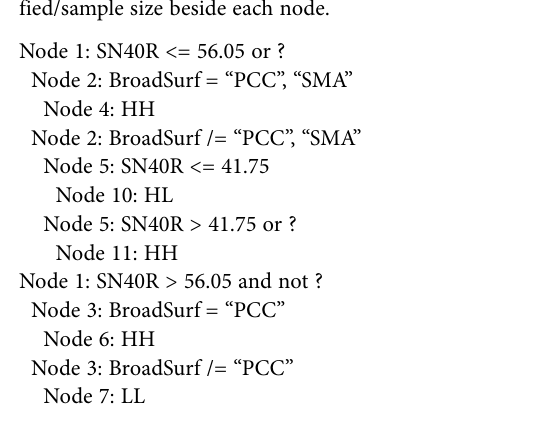
Fig. 7. GUIDE Classification Tree result of hotspots of weather-related crash rate in Wisconsin without functional class variable